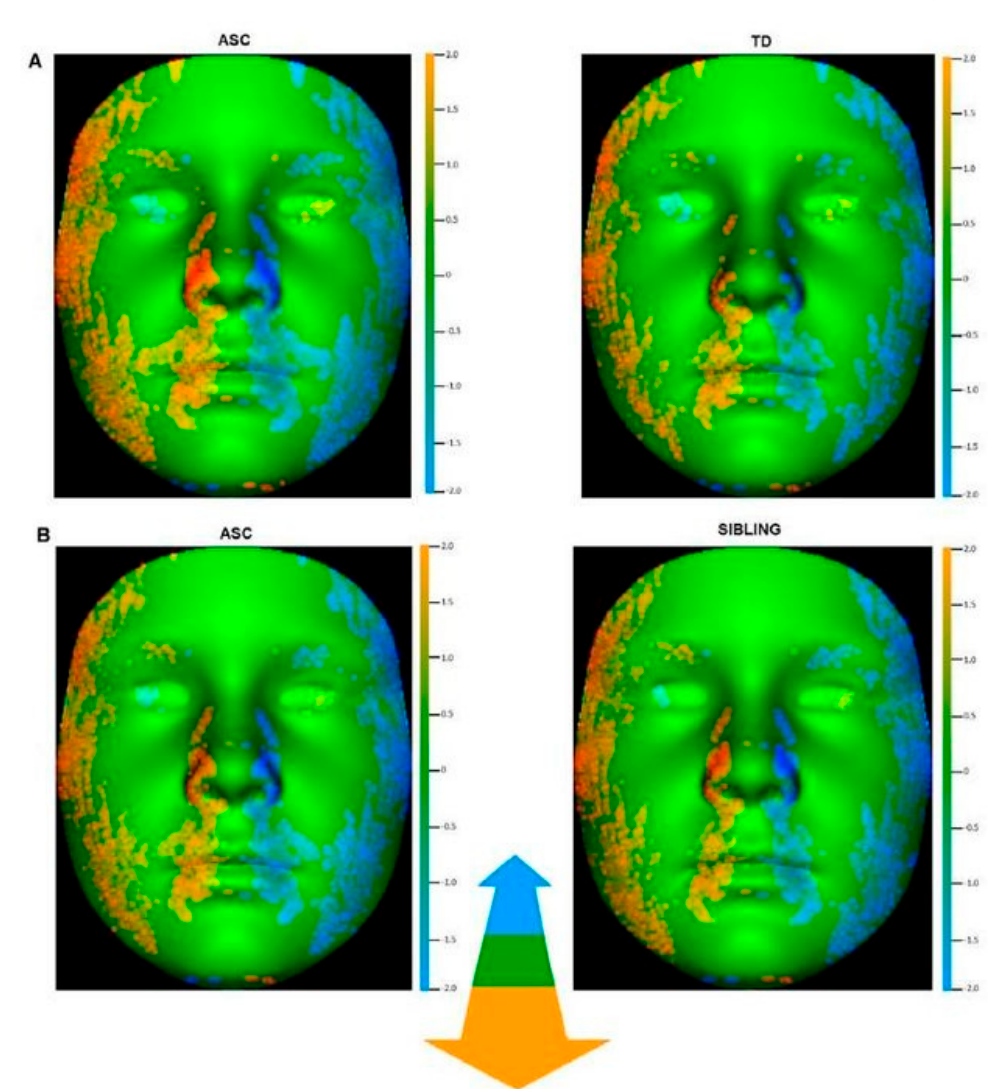
Figure 2. Comparison of depth facial asymmetry in mean original to mean mirrored form for ( A ) autistic children and TD children and ( B ) autistic children and sibling children. The color scale uses orange (or blue) to indicate where individual points on the mean original face is at least 2mm outside (or at least 2mm inside) corresponding points on the mean mirrored face. Figure 2 A illustrate greater right-dominant depth asymmetry compared to TD children and Figure 2 B illustrates greater right-dominant depth asymmetry in autistic children compared to siblings [10].